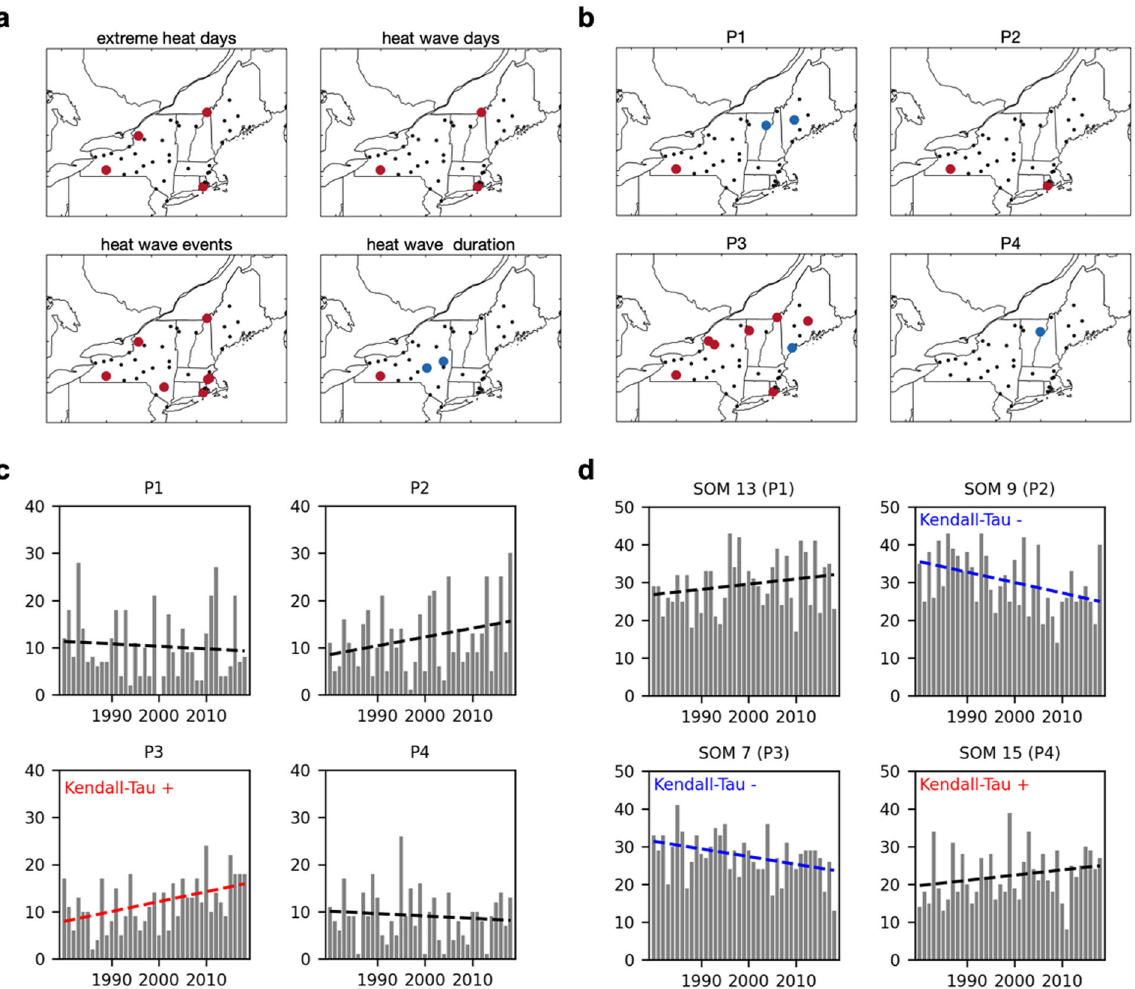
Fig. 5 Trends in heat waves and patterns. Trends in 1980 – 2018 a station extreme heat days, heat wave days, heat wave events, and heat wave duration, and b station heat wave days assigned to P1 – P4, where enlarged dots indicate statistically signi fi cant positive (red) or negative (blue) trends (at 0.05 level). c Frequency (bars) and linear trends (dashed lines) of regional heat wave days assigned to patterns P1 – P4 and d same as c except for the SOMs that are most similar to P1 – P4 days, where dashed lines are red (blue) to indicate statistically signi fi cant positive (negative) trends at the 0.05 level. Trends are determined by linear least squares fi t and signi fi cance is based on the two-sided t-distribution of the Wald Statistic. Additionally, the Kendall ’ s tau-b rank test is considered for c , d , and any signi fi cant trends at the 0.05 level are indicated by text at the top of the